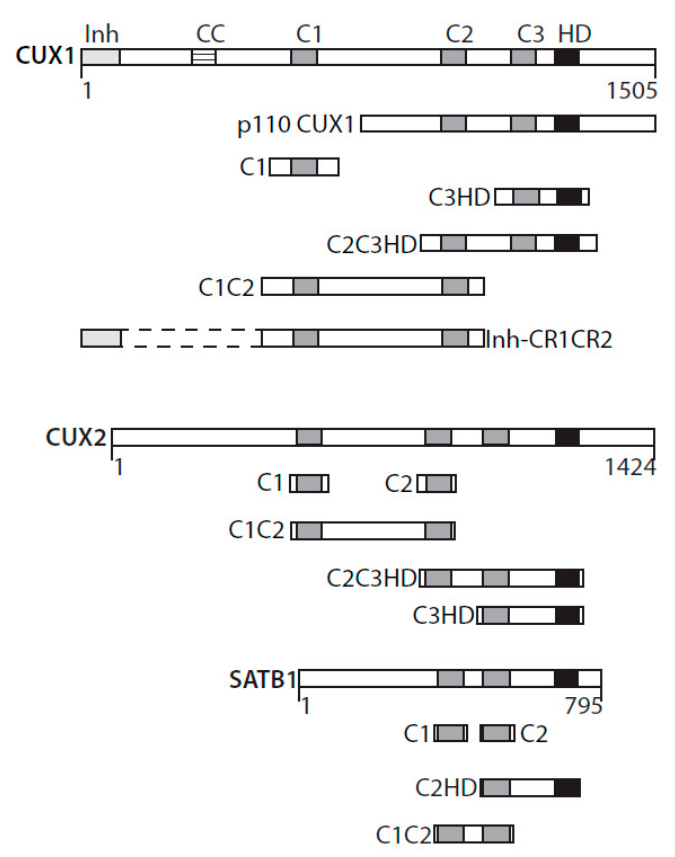
Figure 1. CUT domains active in base excision repair. Diagrammatic representation of CUX1, CUX2, and SATB1 and the recombinant CUT domain proteins active in base excision repair. Inh, DNA- binding inhibitory domain; CC, coiled-coil; C1, C2, C3, CUT domains 1, 2, and 3; HD, homeodomain.